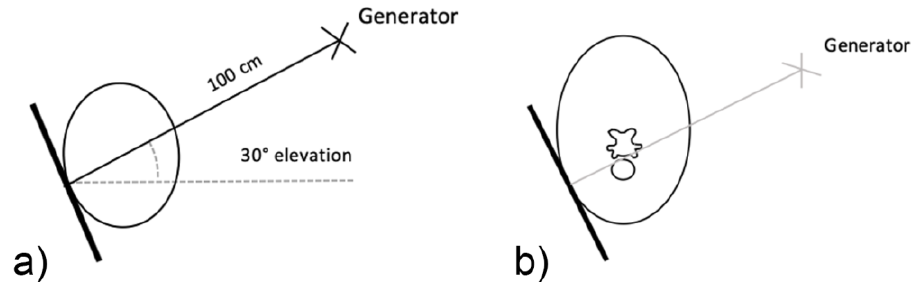
Figure 3. Lateral 30° dorsal-ventral oblique view, left and right side required ( a ). Ideal positioning for image capture and superimposition of the C6 ventral lamina over the trachea ( b ).